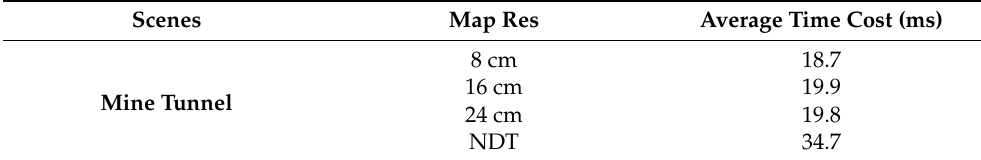
Table 9. Average time cost of scan-to-map matching in underground mine tunnel.